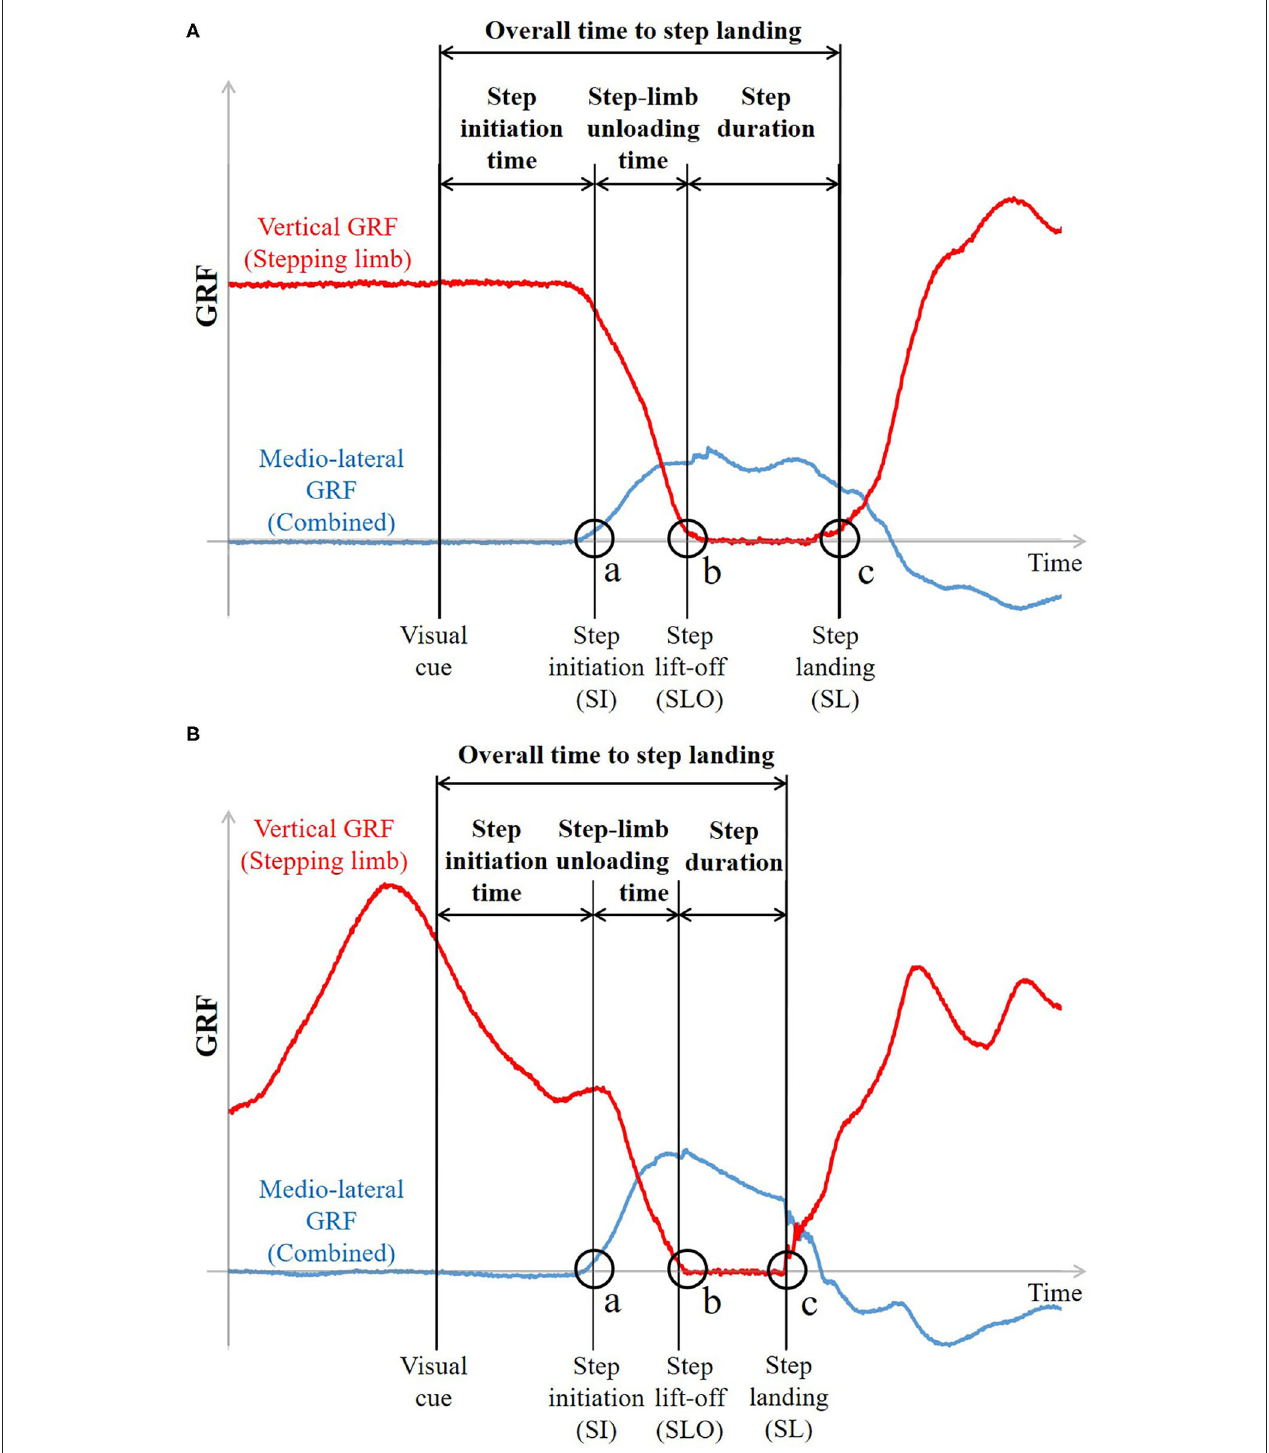
FIGURE 3 | Representative time-history plots of mediolateral and vertical GRFs in (A) NP condition and (B) P condition (EE condition). (a) Step initiation (SI) was defined as the instant when the combined mediolateral GRF in the direction of the stepping limb side first exceeded 10N. (b,c) Step lift-off (SLO) and step landing (SL) instants were detected as the instants when the vertical GRF of the stepping limb first fell below 10N and exceeded 10N, respectively. SI time and SLO time were defined as the time interval from the visual cue to SI and to SLO, respectively. Step-limb unloading time and step duration were respectively defined from SI to SLO and from SLO to SL. Overall time to step landing was defined as the total response time from the visual cue until the instant of first step landing.